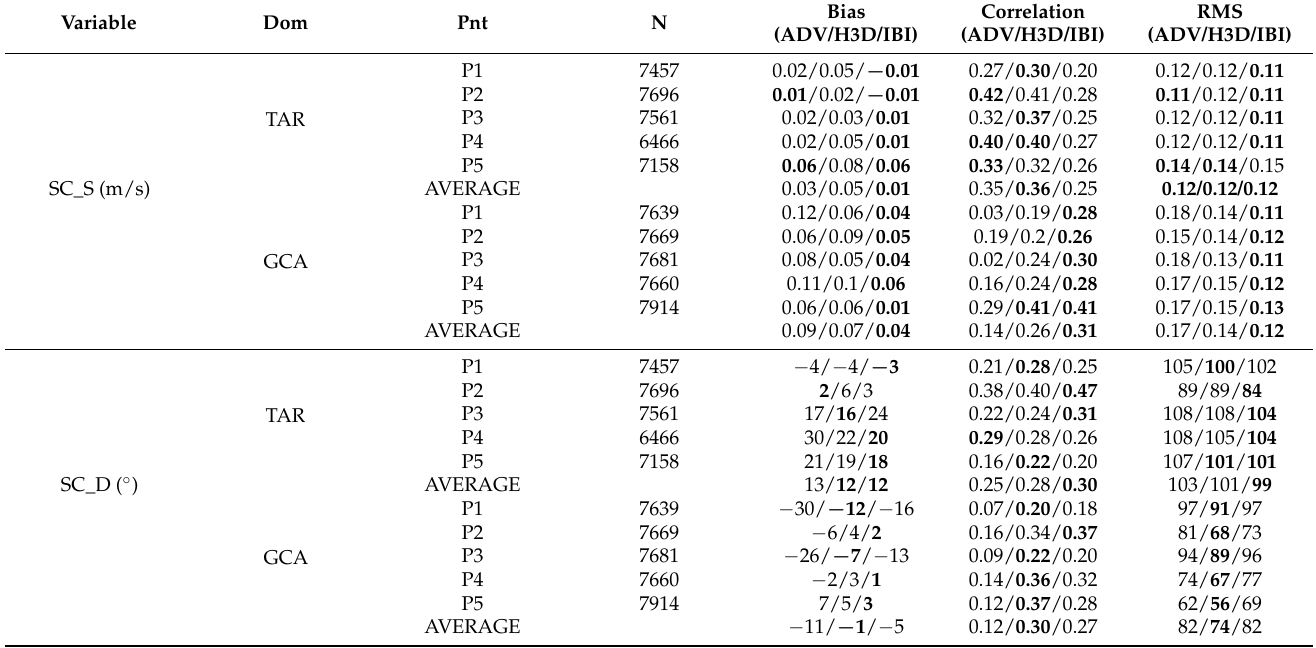
Table 5. Surface current error metrics at Tarragona and Gran Canaria domains vs. HF Radar, at a subset of representative points. The metrics comprise the time range from October 2019 to October 2020. Variables: SC_S (Surface current speed from HF Radar, in m/s), SC_D (Surface current direction from HF Radar, in ◦ ). The domain column identifies each SAMOA system. The Pnt denotes the point ID shown in subpanel c in Figures 6 and 7. The N column counts the available observations (hourly resolution) that have been used for computing the metrics. Error metrics (Bias, Correlation and Root-Mean-Square Error (RMS)) provided for each model solution (SAM_ADV (ADV), SAM_H3D (H3D) and IBI_PHY (IBI)). The last row of each variable represents the average error metric of all the sampling points given a specific SAMOA and test run. Bold numbers highlight the best performing